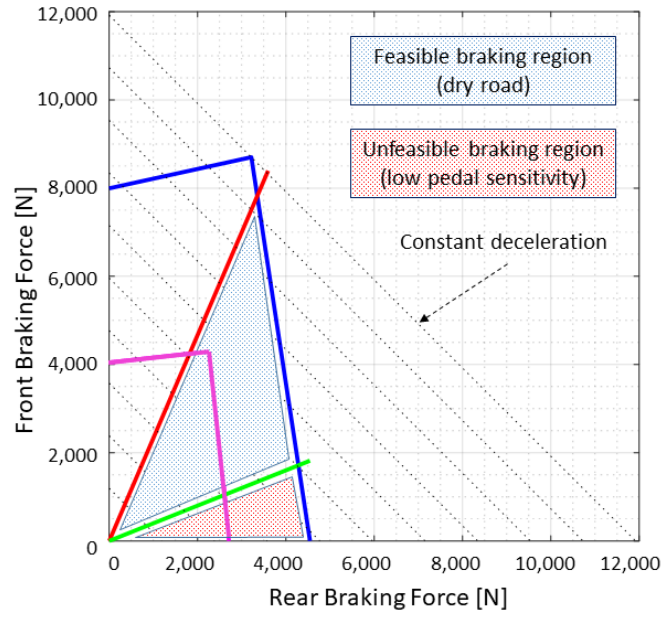
Figure 6. Feasible and unfeasible braking region for a hybridized vehicle.